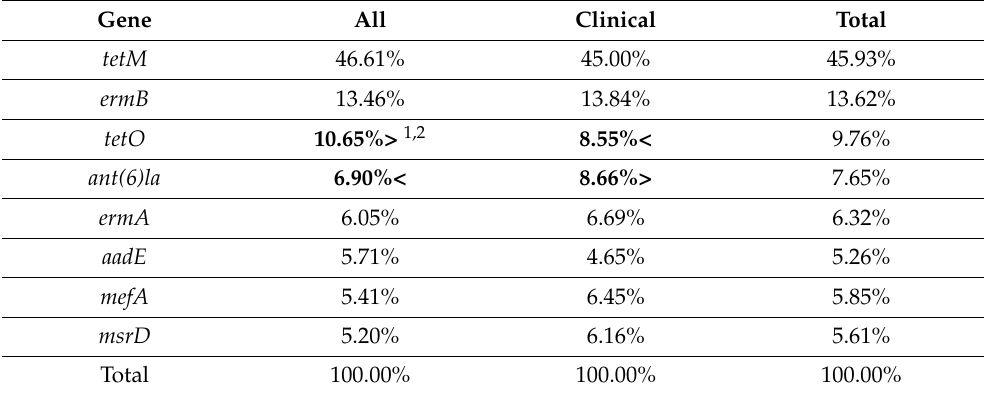
Table 5. Frequency comparison of the most frequently recovered genes (N > 100) between all the sequences and the clinical ones.